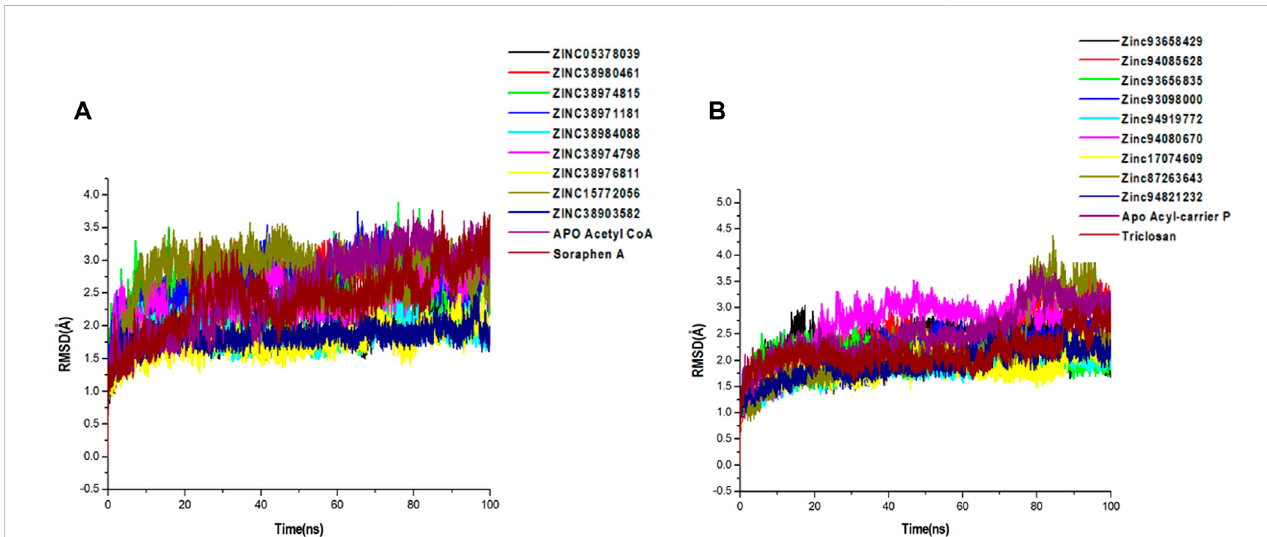
FIGURE 5 Comparative C- α RMSD plots showing the degree of stability and convergence of the hit compounds for (A) Acetyl coenzyme A carboxylase (B) Enoyl- acyl carrier reductase enzyme over the 100 ns MD simulation